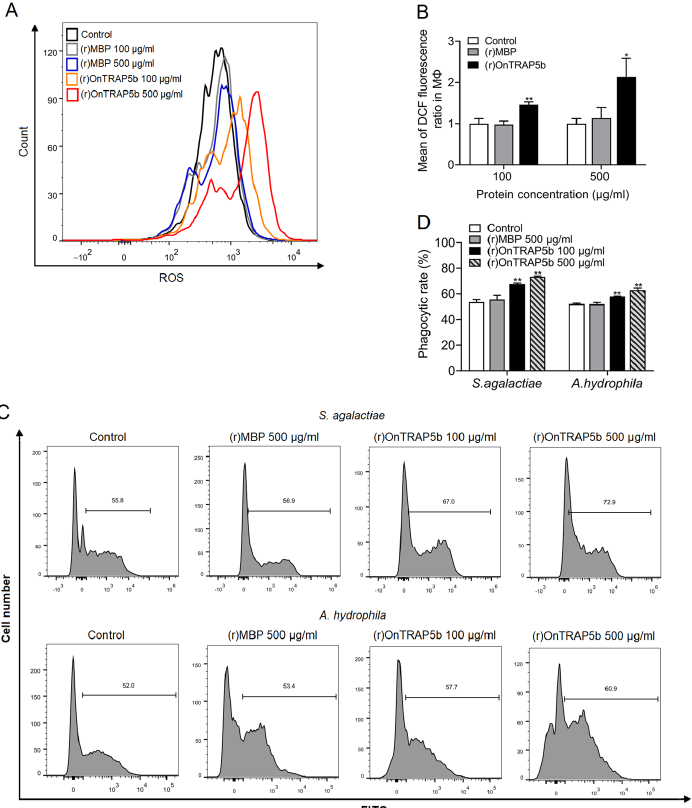
Figure 8. The analysis of ROS production and phagocytic activities in head kidney macrophages upon (r)OnTRAP5b. Head kidney macrophages were stimulated with 100 or 500 µ g/mL (r)OnTRAP5b or (r)MBP, and oxidation of DCFH-DA was measured for 30 min using excitation and emission filters of 488 and 525 nm, respectively ( A ). The mean of DCFH-DA fluorescence with treatment for (r)OnTRAP5b or (r)MBP at doses of 100 and 500 µ g/mL in head kidney macrophages ( B ). Histogram distribution of uptake S. agalactiae and A. hydrophila in head kidney macrophages with treatment for (r)OnTRAP5b or (r)MBP at doses of 100 and 500 µ g/mL ( C ). The phagocytic rate of uptake S. agalactiae and A. hydrophila in head kidney macrophages with treatment for (r)OnTRAP5b or (r)MBP at doses of 100 and 500 µ g/mL ( D ). The values are shown as means ± SD ( n = 3), n , the number of times the experiments were performed. ** p < 0.01, * p <